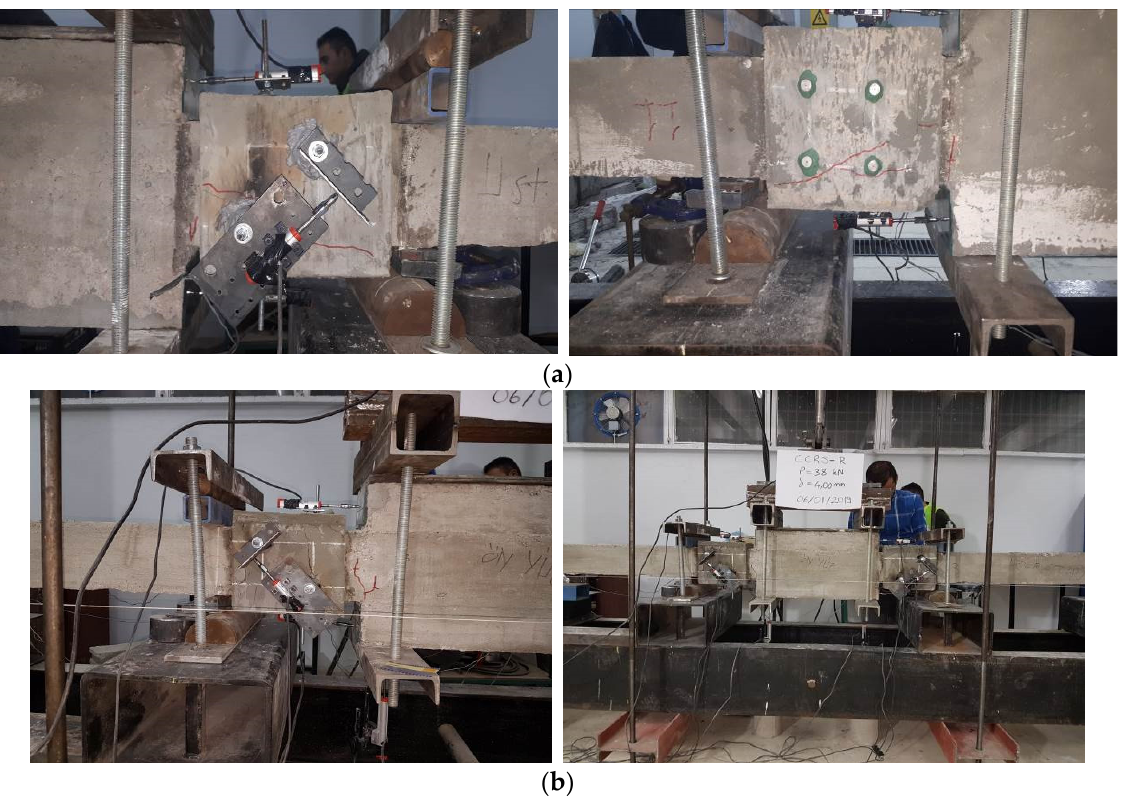
Figure 14. Flexural and shear cracks in specimens . ( a ) DS-R; ( b ) CCRS-R.